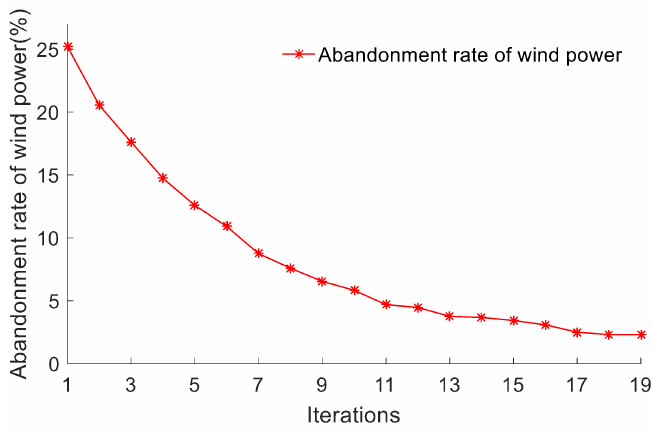
Figure 12. Convergence curve of the abandonment rate of wind power.